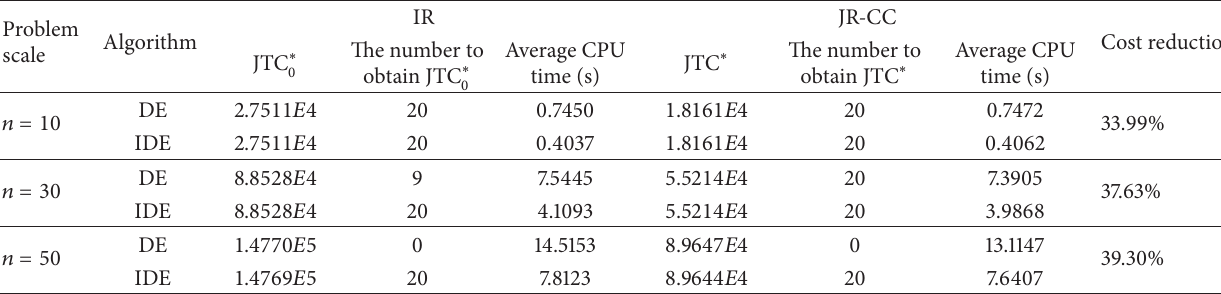
Table 7: The results of different scales under different algorithms.